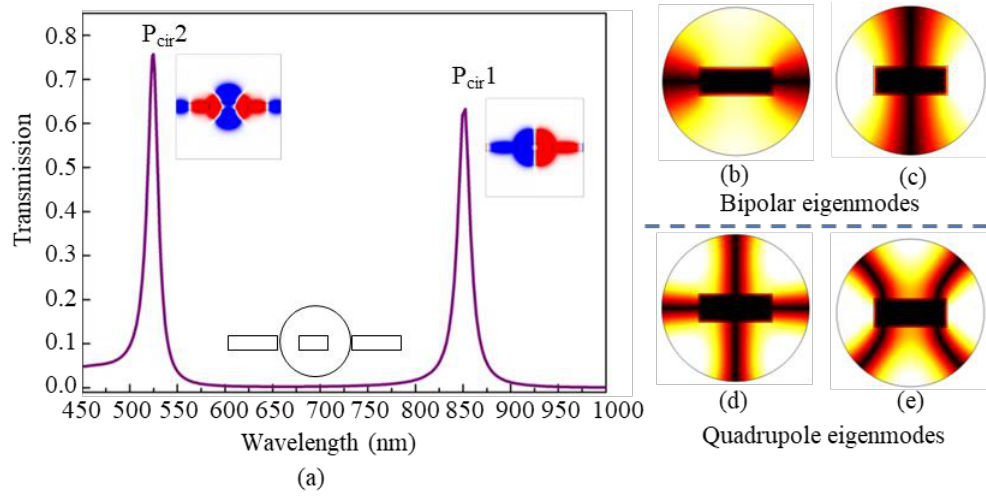
Figure 3. ( a ) The transmission of the metal-core circular cavity coupled with a waveguide, where the black-line inset shows the detailed structure, and the color insets show the magnetic-field H z distributions at the transmission peaks of P cir 1 ( λ = 852 nm) and P cir 2 ( λ = 526 nm); ( b , c ) the | H | distributions of dipole eigenmodes, and ( d , e ) the | H | distributions of quadrupole eigenmodes, for the metal-core circular cavity without coupling with a waveguide.